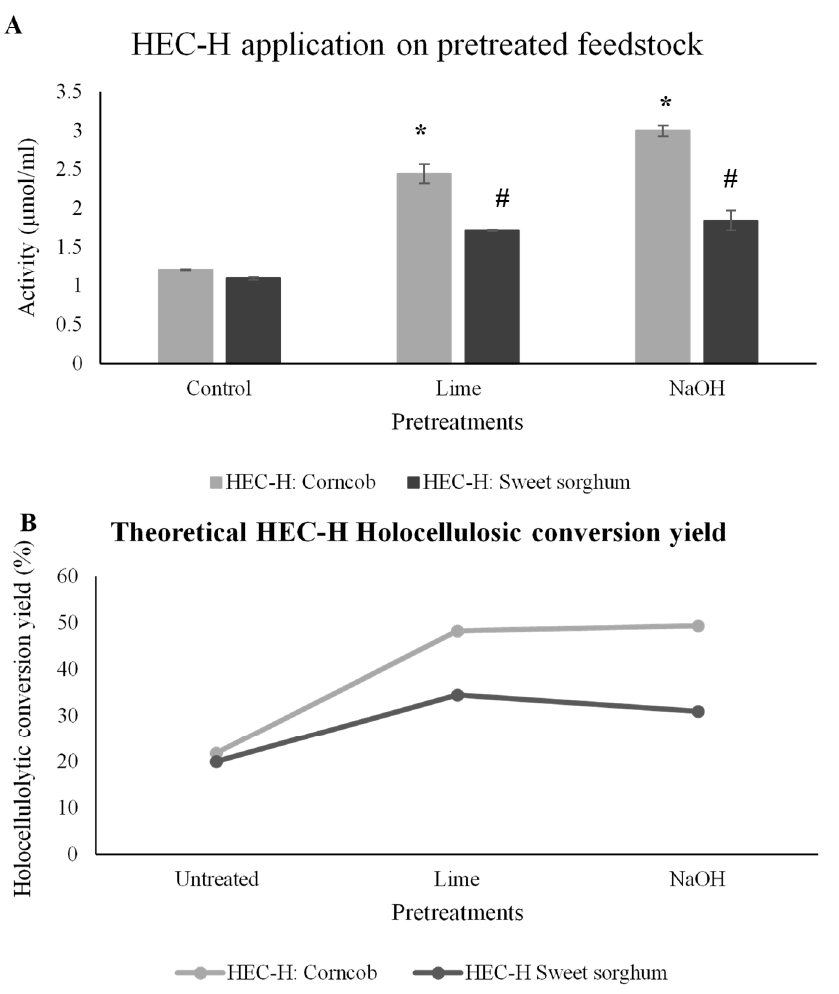
Figure 3. Application of the holocellulolytic enzyme cocktail (HEC-H) formulated with multifunctional enzymes (MFEs) and exoglucanase (Exg-D) derived from a termite bacterial hind-gut metagenome on pretreated sweet sorghum bagasse (SSB) and corncob (CC). ( A ) Activity in µ mol / min, and ( B ) holocellulose conversion yields (total reducing sugars produced by HEC-H divided by the sum of cellulose and hemicellulose content) of SSB and CC samples. * Represents p -values < 0.01 and # represents p -values < 0.05. All experiments were performed in triplicate and the values represent means ± SD.